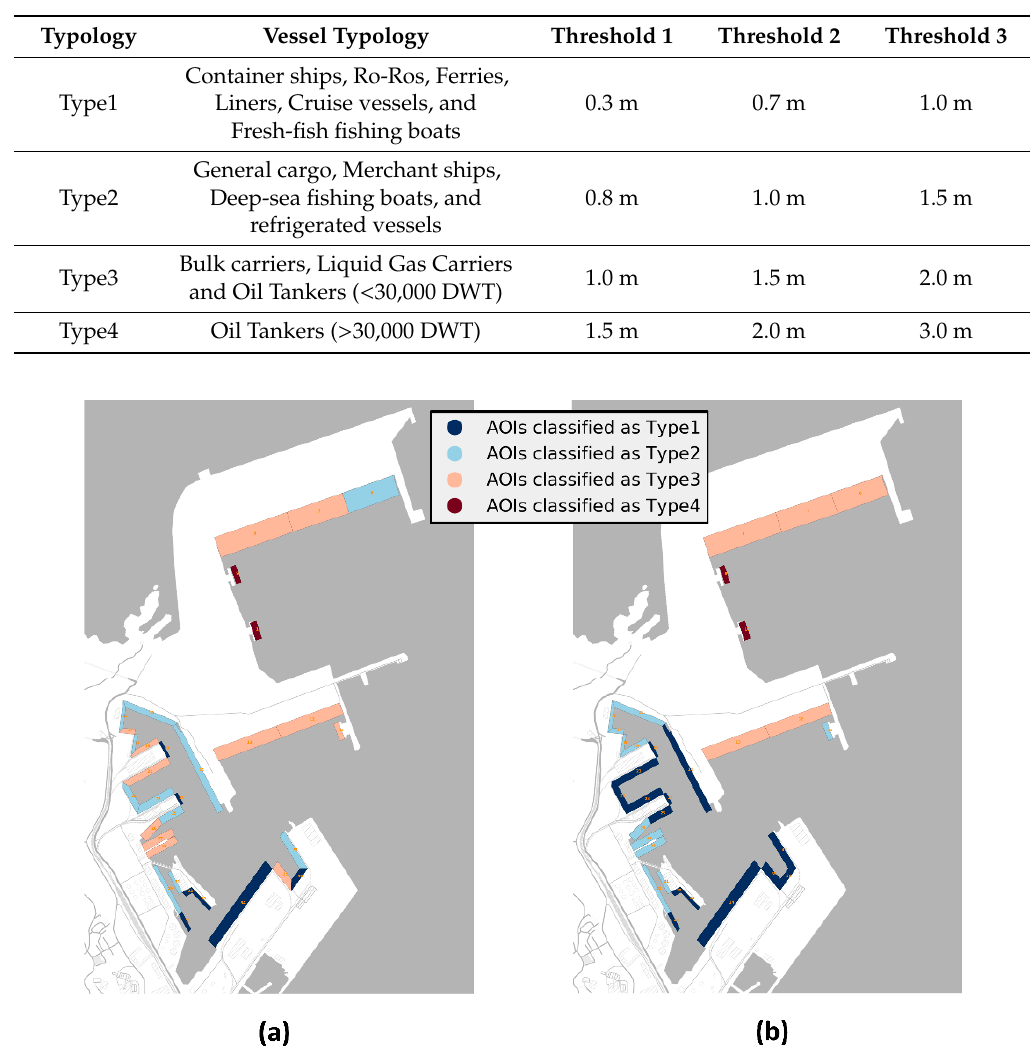
Figure 4. Classification of the AOIs at the Port of Gijón (Spain) into four typologies: ( a ) According to the current real uses; ( b ) According to a homogenous wave agitation criterion based on the results from all the propagated metocean scenarios.